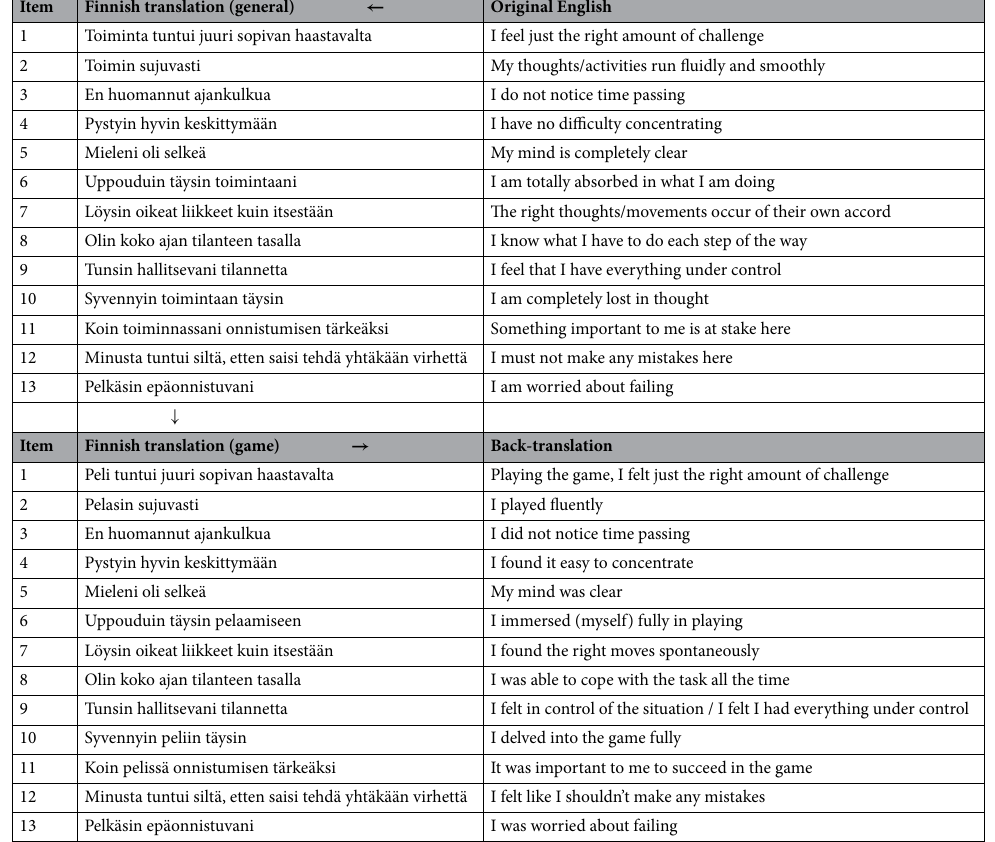
Table 1. FSS items in original English form; translated to Finnish in general form for the validation study and game-specific form for 31 ; and back-translated from game-specific form to English for verification.